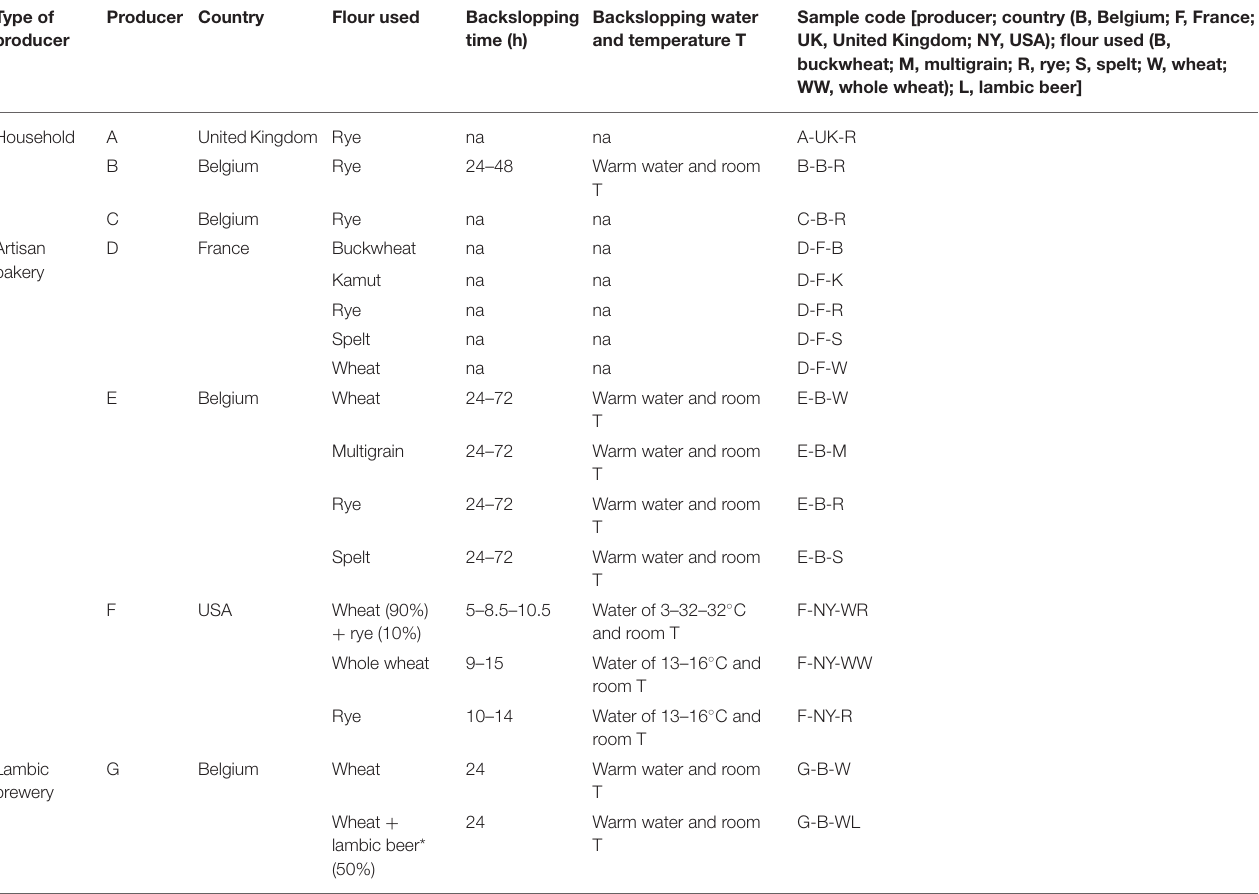
TABLE 1 | Characteristics of 17 sourdough samples from backslopped sourdoughs of different origins collected during the present study. Type of